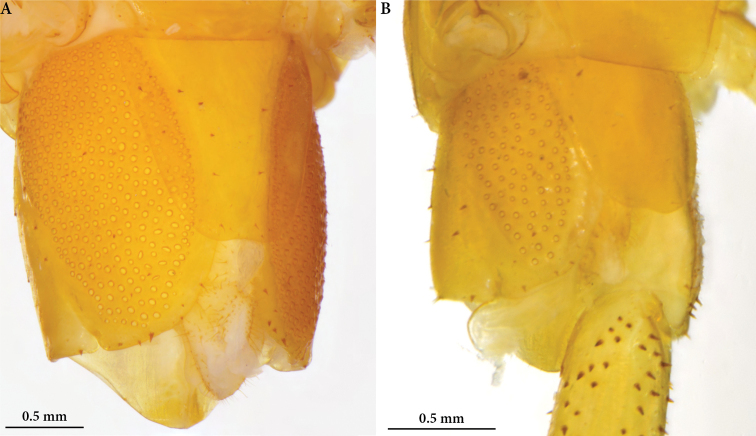
Cryptops spp., Coxopleural pore field ACryptops
speleorex sp. nov., holotype BCryptops
anomalans, Pirin Mts (Bulgaria).